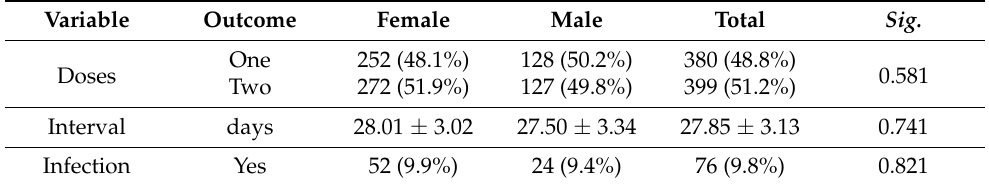
Table 3. COVID-19-related anamneses of Turkish healthcare workers vaccinated by CoronaVac, from